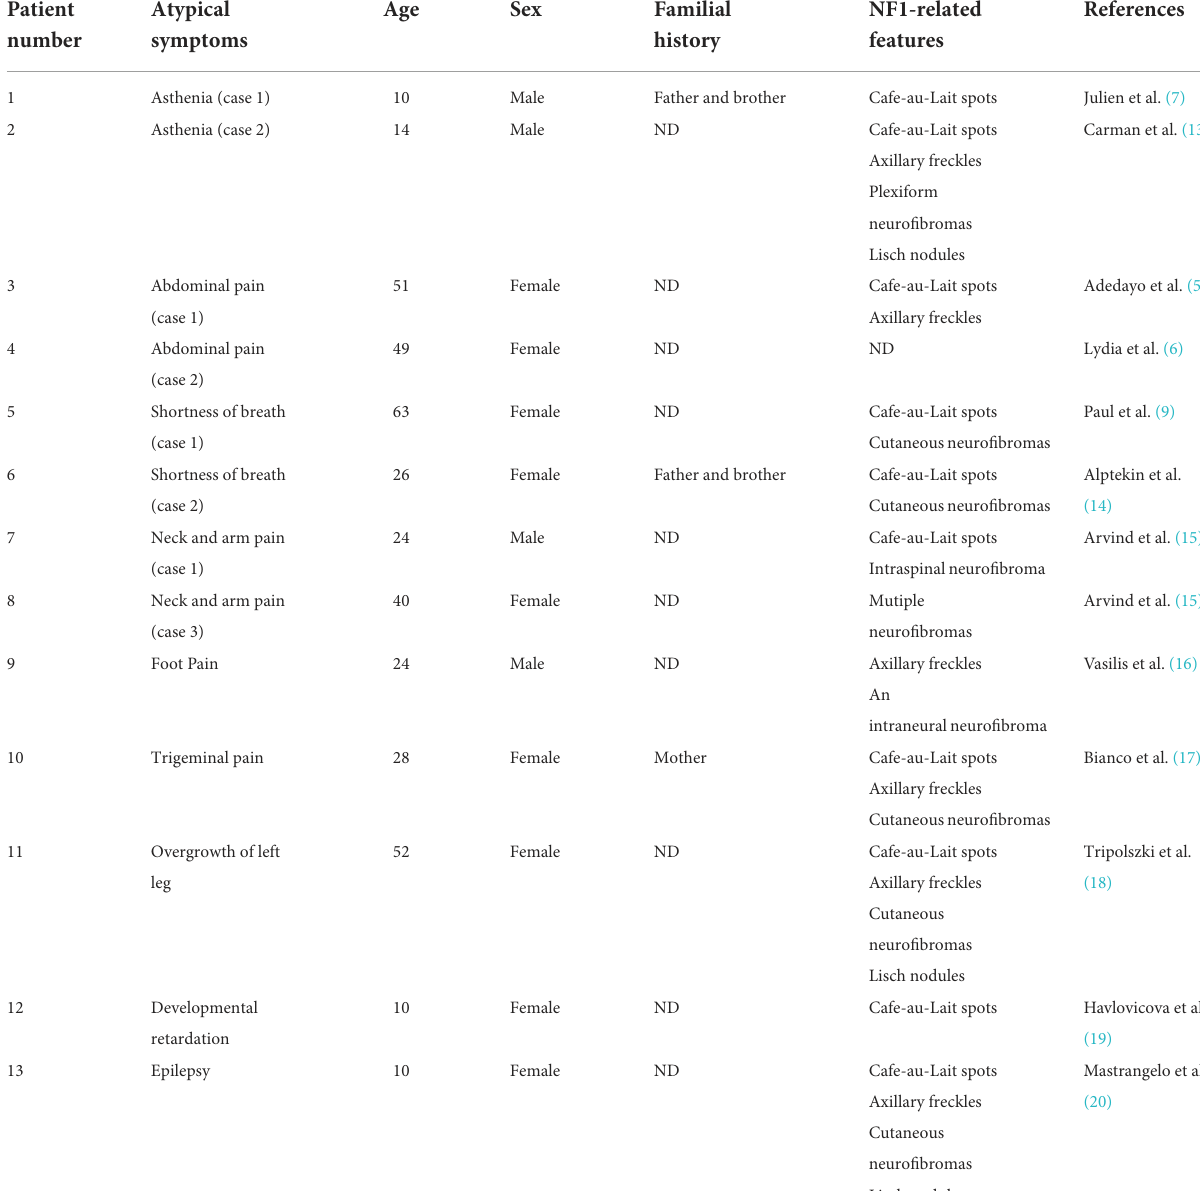
TABLE 1 Atypical symptoms of NF1 cases reported in English clinical